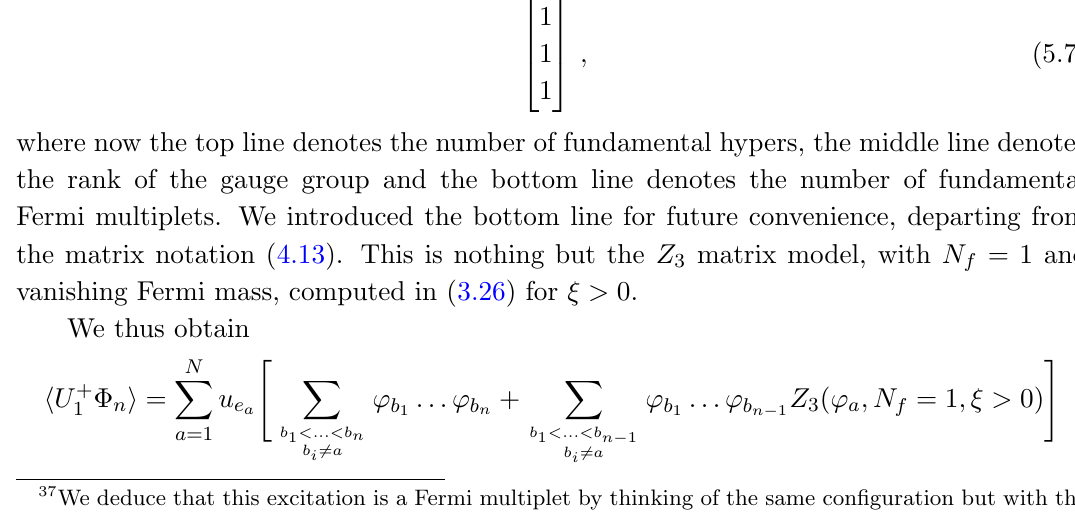
Figure 14 . A string pattern contributing to the correlator h U + the right (after Hanany-Witten move) allows us to read the SMM on the D1